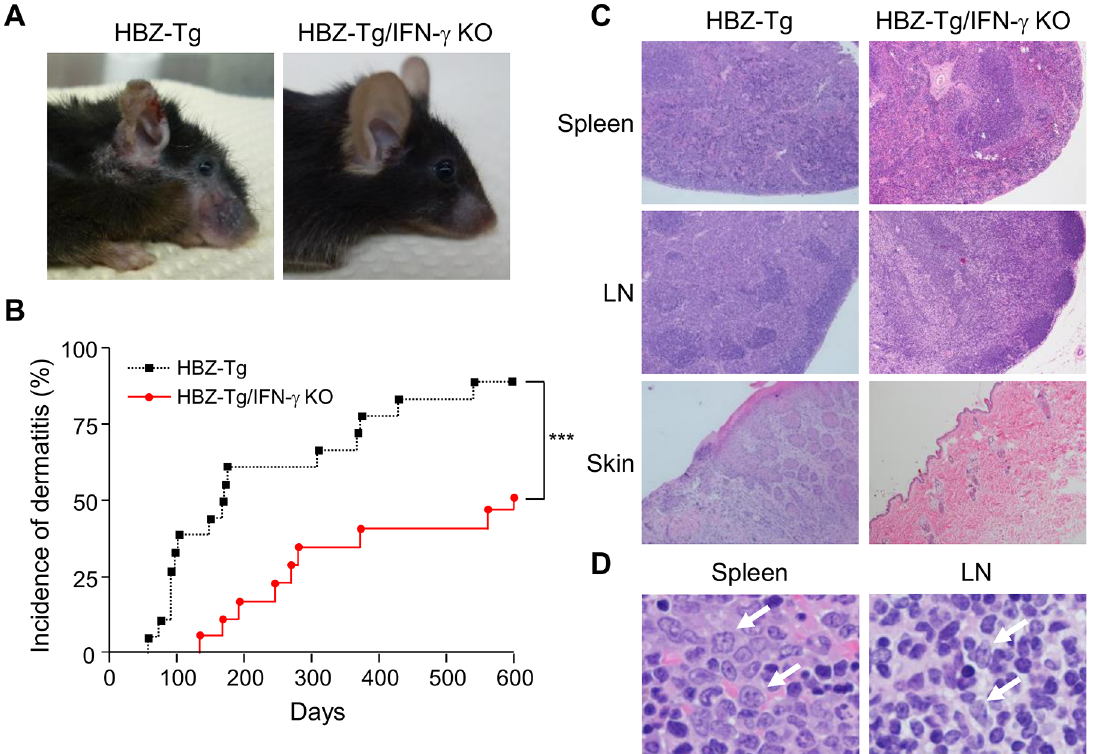
Fig 1. Incidence of inflammation and lymphoma is decreased in HBZ-Tg/IFN- γ KO mice. (A) HBZ-Tg and HBZ-Tg/IFN- γ KO mice at 24 weeks of age. HBZ-Tg mice developed dermatitis around the ears, eyes, and back. HBZ-Tg/IFN- γ KO mice did not develop dermatitis. (B) 90% of HBZ-Tg developed dermatitis by 2 years of age. However, in HBZ-Tg/IFN- γ KO mice, the onset of dermatitis was delayed and its incidence was lower than in HBZ-Tg mice. *** indicates significant differences p < 0.01. (C) Histological analysis of HBZ-Tg and HBZ-Tg/IFN- γ KO mice (x10). The spleen of an HBZ-Tg mouse shows a diminution of the structure and a diffuse infiltration of atypical cells in red palps. The lymph node of HBZ-Tg shows a focal diminution of nodal structures and a diffuse infiltration of atypical cells in paracortical area. The skin of HBZ-Tg shows hyperkeratosis of epidermis. However, the spleen, lymph node and skin of HBZ-Tg/IFN- γ KO show normal structures. (D) Lymphomas developed in spleen and lymph nodes of HBZ-Tg mice with dermatitis. In the high magnification (x60), the spleen of an HBZ-Tg mouse shows a diffuse infiltration of atypical large lymphoid cells with irregular nuclei, and the lymph node shows atypical large lymphoid cells, also. Abnormal cells are indicated by white